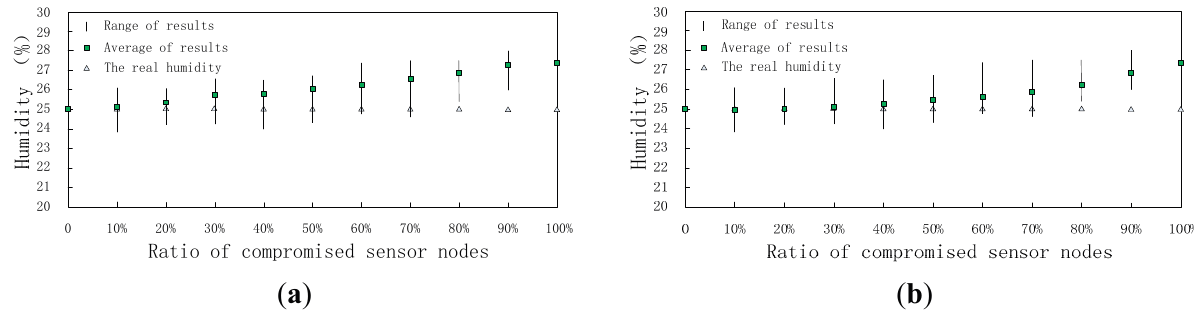
Figure 15. Data fusion results of humidity versus ratio; ( a ) without DCHM and ( b ) using